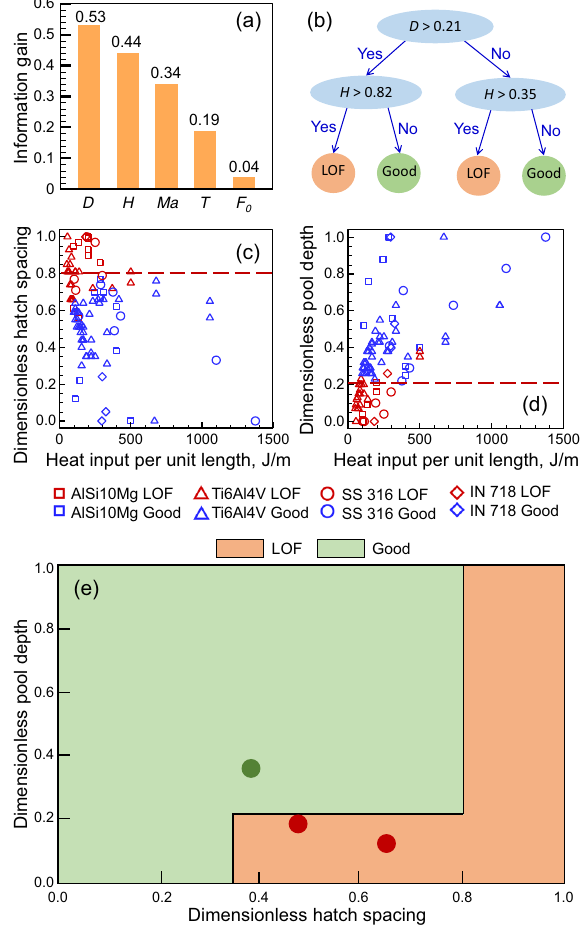
Fig. 4 Hierarchical importance of the mechanistic variables on lack of fusion and decision tree to predict the defects. a Hierarchical importance of the fi ve mechanistic variables on lack of fusion defect computed using information gain. b A decision tree was constructed based on the 101 experimental cases to predict the formation of the lack of fusion defect. ‘ LOF ’ indicates the cases with lack of fusion defect and cases where lack of fusion was not observed experimentally are denoted by ‘ Good ’ . Variations of c dimensionless hatch spacing and d dimensionless pool depth with heat input per unit length (laser power/scanning speed) for 101 experimental cases. The data for each alloy was made dimensionless by dividing by its maximum value for the alloy so that the data of all four alloys could be plotted on the same scale. e A process map of dimensionless hatch spacing and dimensionless pool depth indicating the regions of ‘ LOF ’ (with lack of fusion voids) and ‘ Good ’ (without lack of fusion voids) was constructed using the decision tree results. The map is tested using independent experimental data of Ti-6Al-4V parts 55 made using PBF-L. The green circle corresponds to a case without lack of fusion and the two red circles indicate two cases where voids were